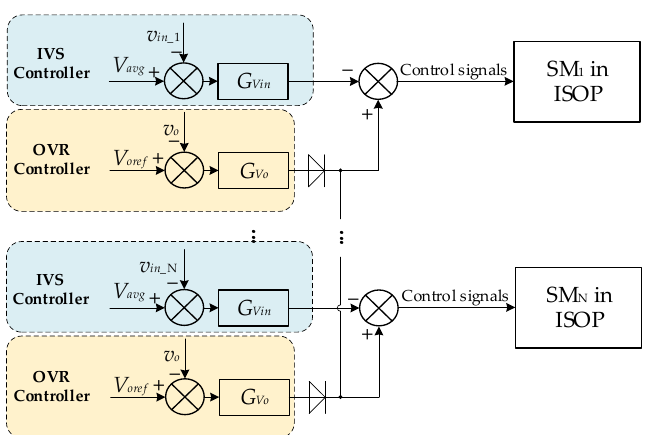
Figure 5. Decentralized control block of the OVR–IVS control.